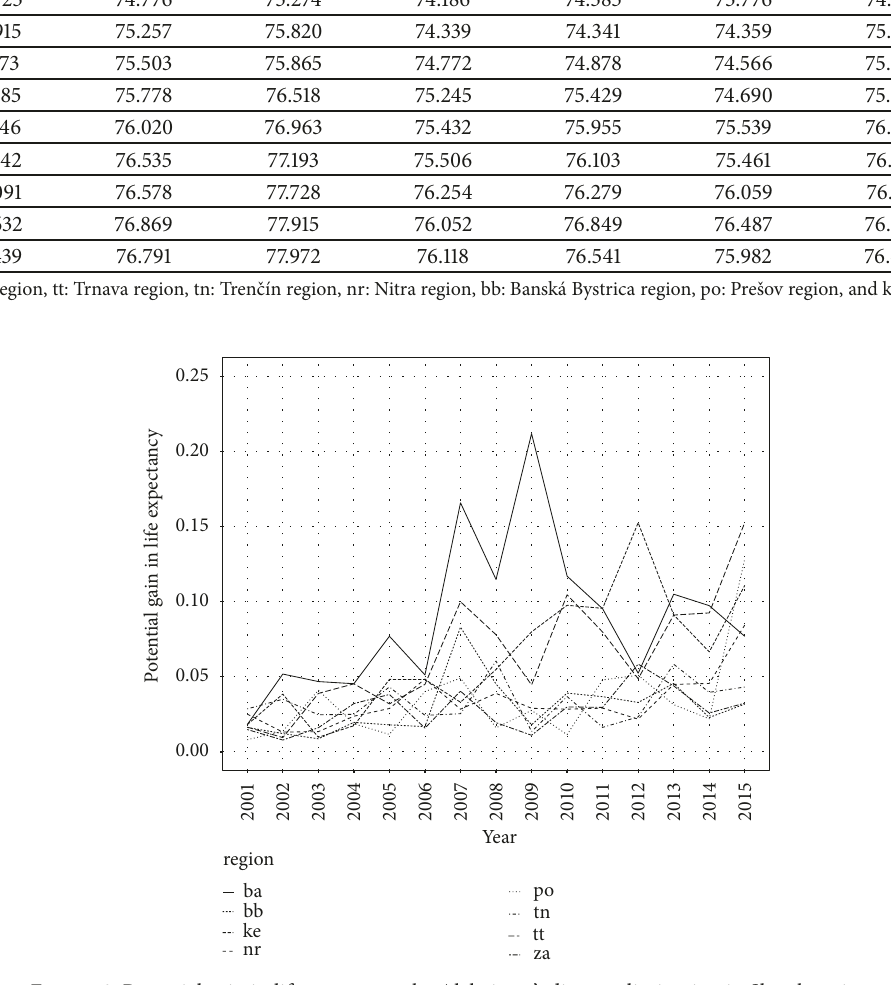
Figure 3: Potential gain in life expectancy by Alzheimer’s disease elimination in Slovak regions.